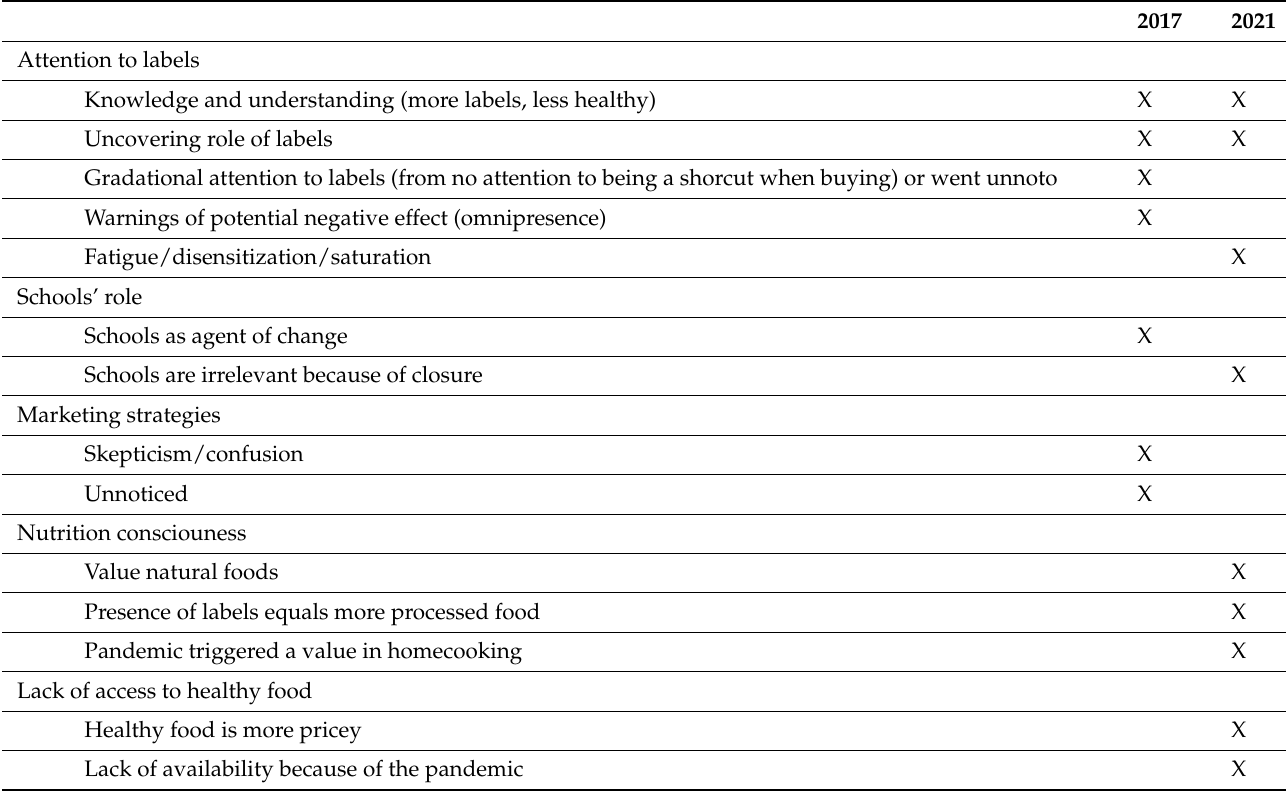
Table 2. Comparison of themes that were present in the focus groups of mothers 2017 vs.